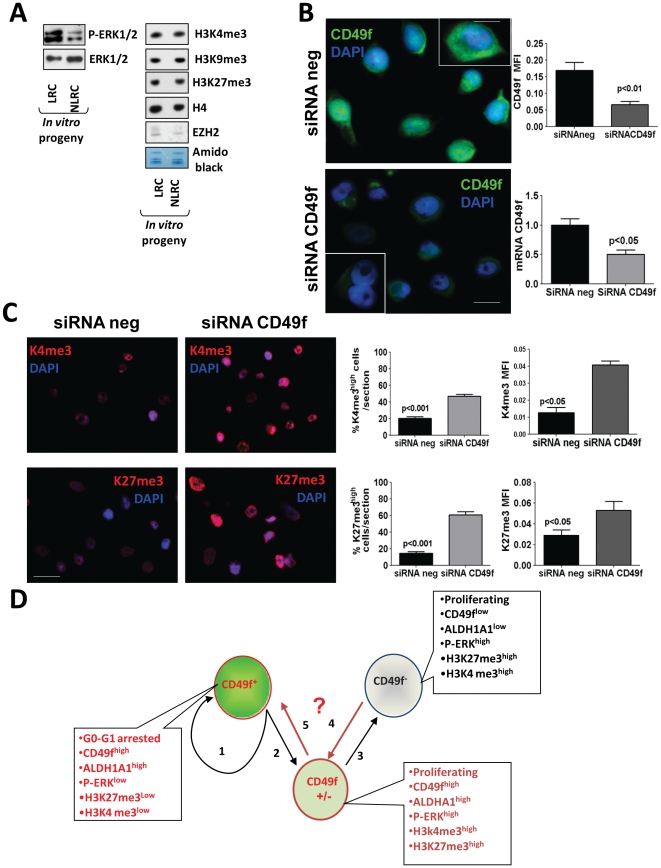
Characterization of H3 post-translational modifications upon knockdown of CD49f.(A) Immunoblot of phospho- and total-ERK1/2, H3K27me3, H3K4me3, H3K9me3 and EZH2 expression in LRCs and NLRCs sorted and expanded in vitro. Total ERK1/2 and Amido black were used as loading controls. (B) Inhibition of CD49f in HEp3 cells grown in vivo 6 days. Left panels: representative images of CD49f in HEp3 cells transfected with a scrambled siRNA (siRNA neg) or with a siRNA CD49f. The cells were permeabilized, thus CD49f signal bathes the whole cell but primarily the cytosol (scale bar = 60 µm). Insets, overlay of CD49f and DAPI, showing the CD49f characteristic membrane and cytosolic staining (Scale bar = 40 µM). Upper right graph- quantification of CD49f mean fluorescence intensity (MFI). Lower right graph,-quantification of CD49f expression by qPCR. (C). Representative images of K4me3 and K27me3 in HEp3 cells transfected with a scrambled siRNA (siRNA neg) or with a siRNA CD49f. Left panels- standard fluorescence microscopy images – scale bar = 80 µm. Quantification of K27me3high and K4me3high percentage of cells and mean fluorescence intensity is shown on the graphs on the right. Graphs show mean ± SD of three independent tumors. p-values estimated using Mann-Whitney non-parametric test. (D) Scheme depicting the hypothetical behavior of different populations in HNSCC tumors. Marker high (CD49f+) and marker low (CD49f−) populations within HNSCC tumors can be defined by their corresponding programs characterized by the markers indicated in the dialogue boxes. CD49f+ can self-renew (path 1) or after transiting through an intermediary state (CD49f+/−) (Path 2) fully reprogram into CD49f− (Path2+3). The intermediary state (CD49f+/−) is defined by default by the markers in the dialogue box. The MTP model proposed that CD49f− cells can also transit through the intermediary state (Path 4) to then fully reprogram into CD49f+ (Paths 4+5). Our model also considers that the different paths are stochastic and tumor cells might transition back and forth between the different states. A remaining open question is what controls the dynamic plasticity that drives the alternation between these states (question mark).